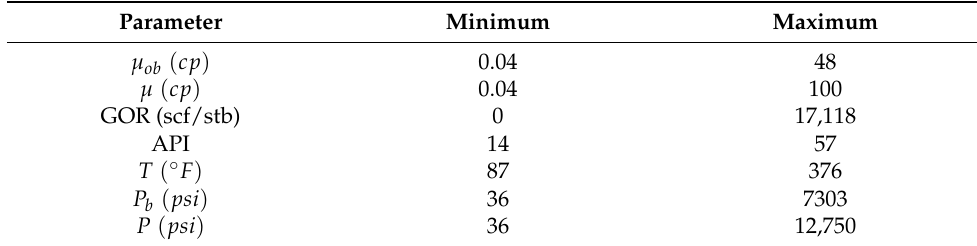
Table 6. Database fluid properties range.